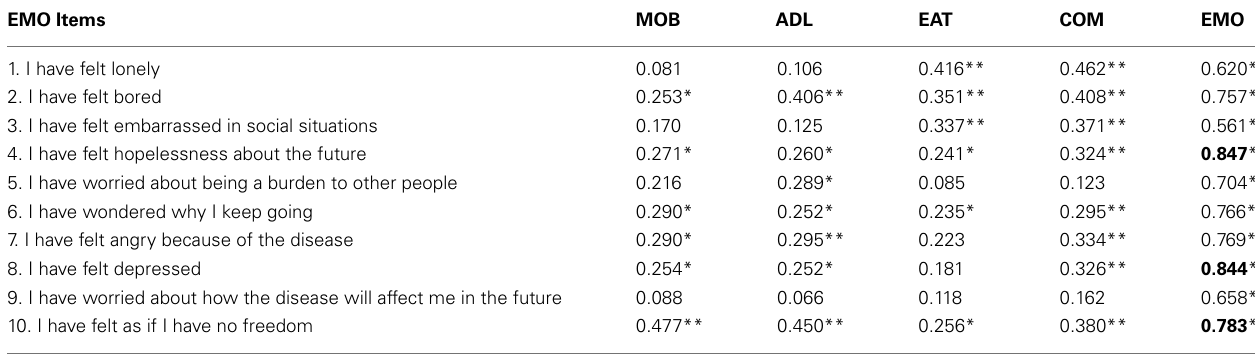
Table 8 | Correlations between EMO items and other areas at the second evaluation. EMO Items